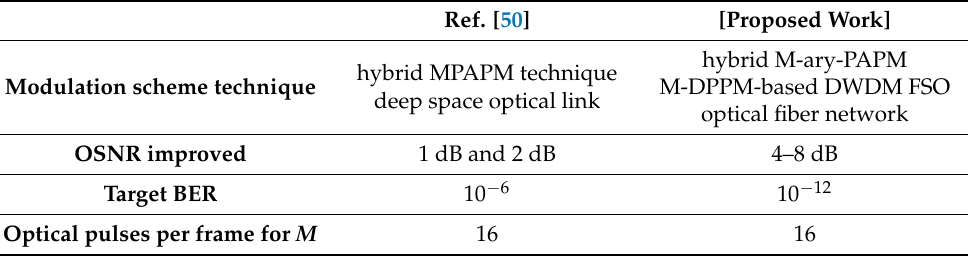
Table 4. Performance comparison of proposed M-ary DPPM-M-PAPM based-DWDM-FSO optical fiber link with reference